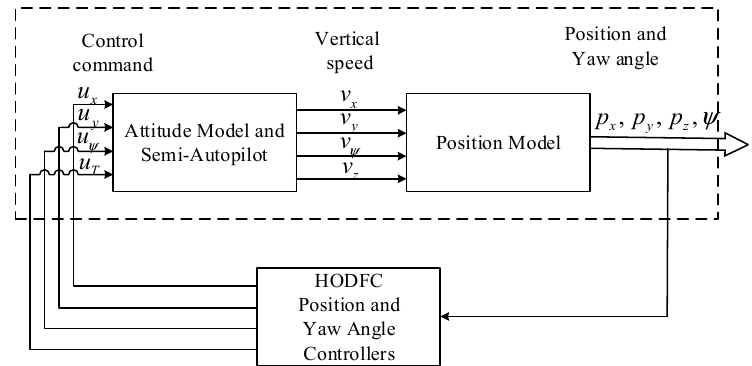
Figure 2. Closed-loop block diagram of position control based on